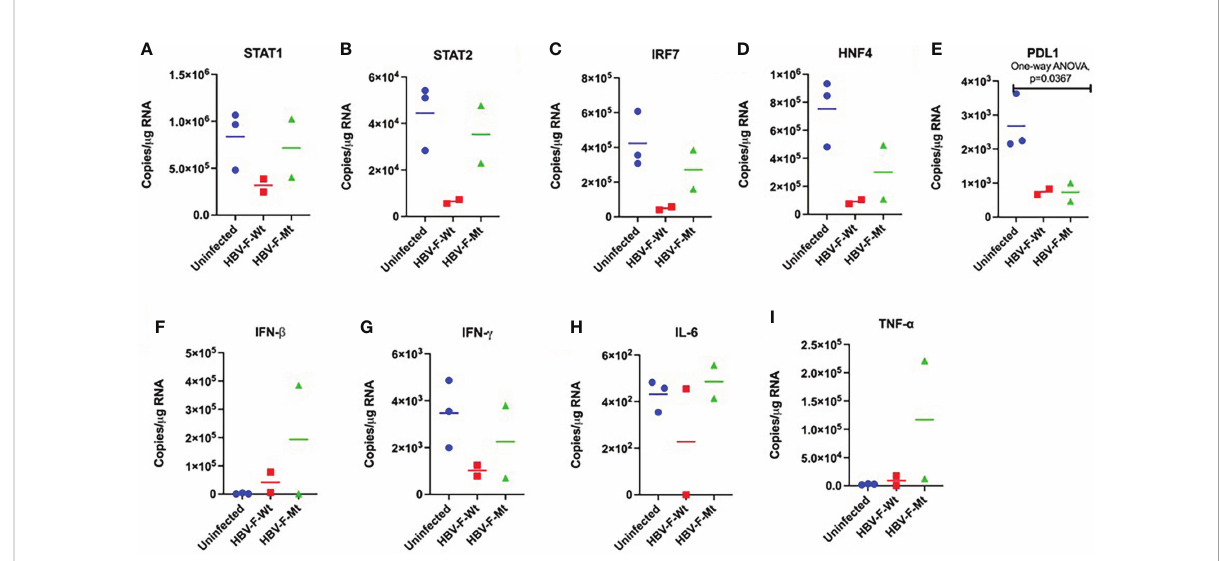
FIGURE 3 Changes in the intrahepatic transcription factors and cytokines in acute HBV-F Wt/Mt infection in tree shrews. The mRNA expression of transcription factors, including (A) STAT1 (B) STAT2 (C) IRF7 (D) HNF4 , and immune checkpoint (E) PDL1 , and cytokines, including (F) IFN- b (G) IFN- g , (H) IL-6 , and (I) TNF- a in HBV-F Wt/Mt-infected tree shrews at 14 dpi. We performed the statistical analysis, and the P values are shown if they are statistically signi fi cant. Thick horizontal lines indicate arithmetic